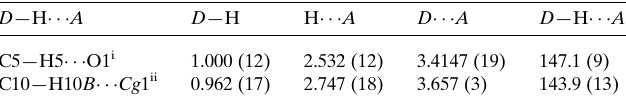
Table 2 Experimental details. Crystal data Chemical formula